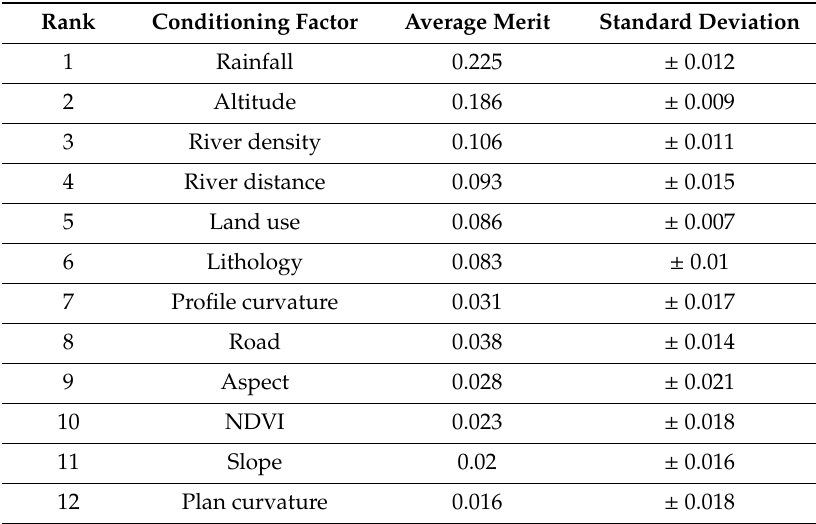
Table 3. The most e ff ective factors for gully erosion occurrence.